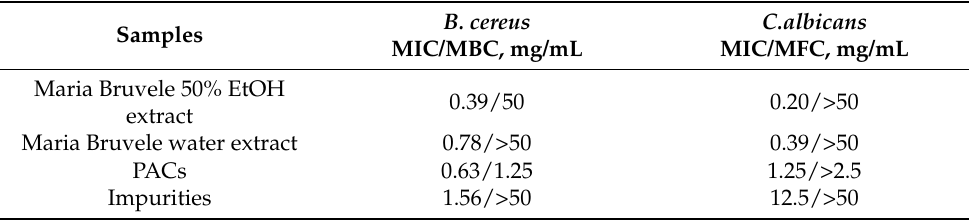
Table 3. PACs’ role in anti-microbial activity against B. cereus and C.albicans . Samples